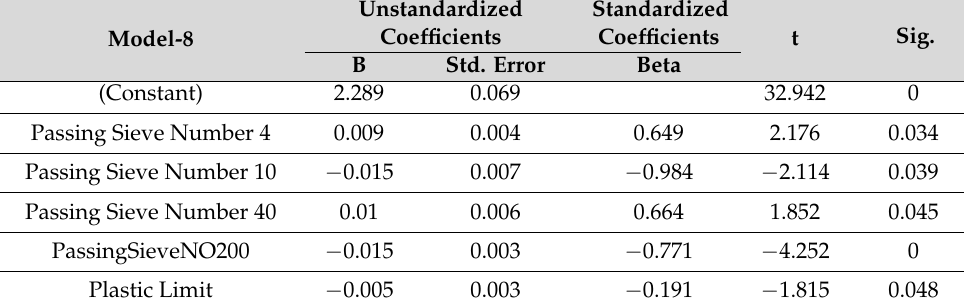
Table 9. MDD prediction model.